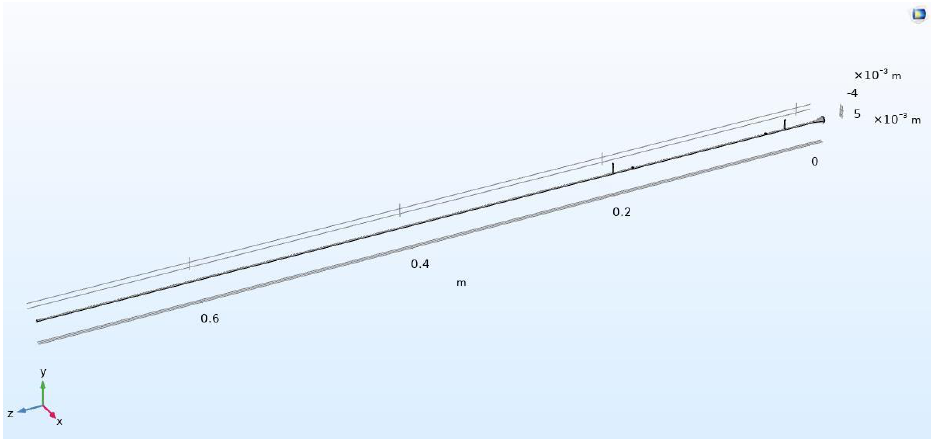
Figure 2. Measured pipeline’s internal flow channel